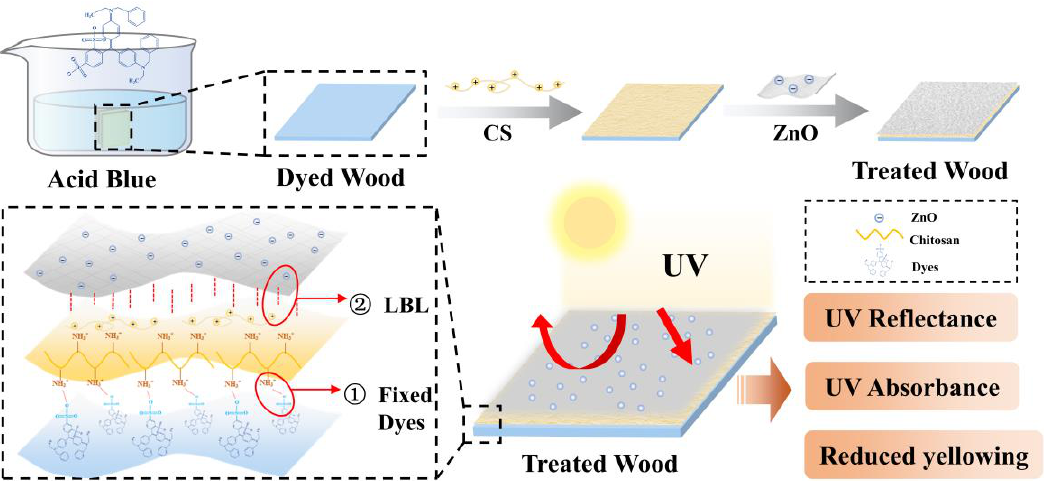
Figure 10. Preparation details and mechanism of the treated wood.